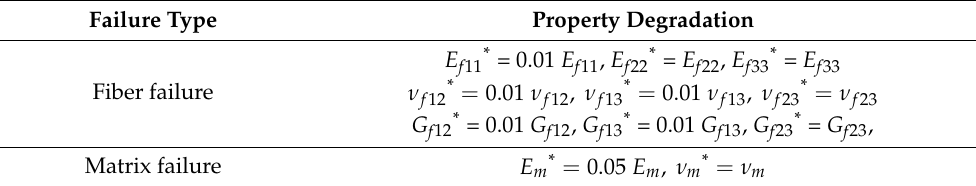
Figure 12. Flowchart of implementing the MMF3-based procedure in the multi-scale failure analysis of plain-woven fabric composites. Table 11. Material property degradation scheme at the constituent level. Symbols on the left side of the equations with the superscript of * represent the degraded properties of the constituents and the degradation factors fit well with the experimental